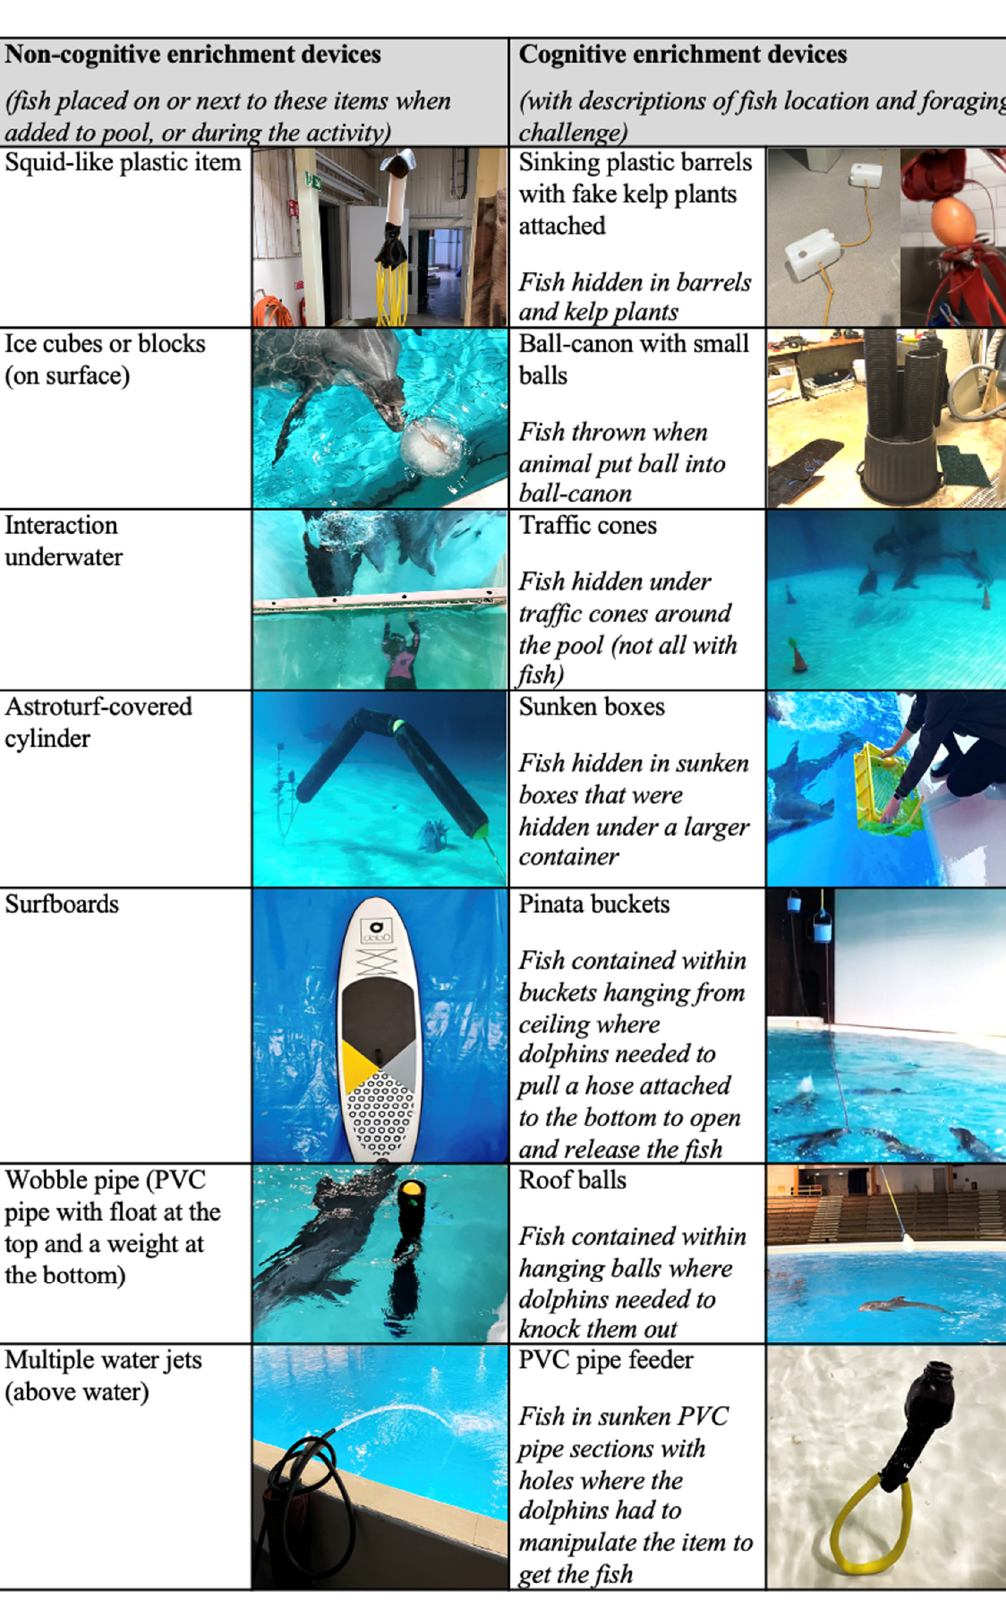
Figure 1. List of 14 devices provided during each of the non-cognitive and cognitive enrichment treatment weeks during the study.